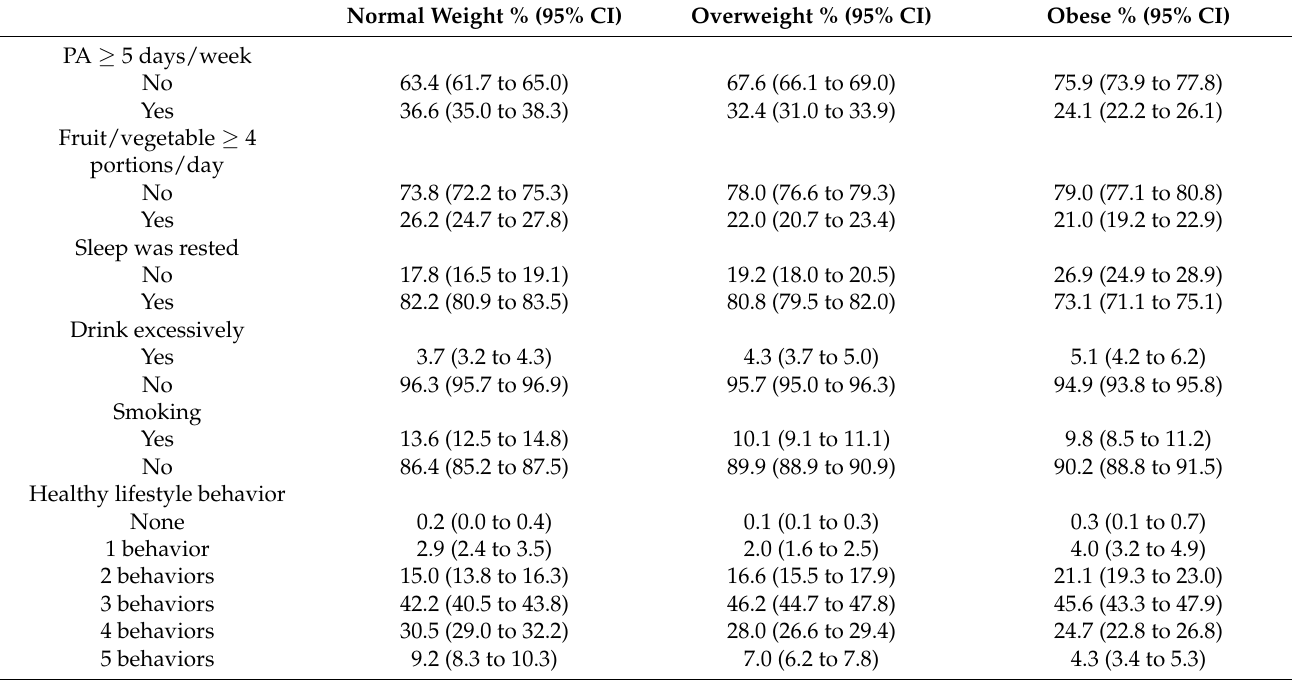
Table 2. Prevalence of healthy lifestyle behavior among all participants by body mass